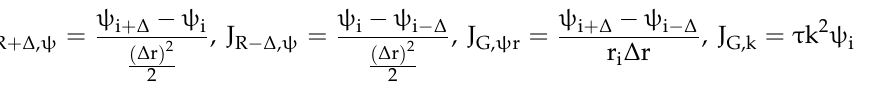
Figure 5. Nomenclature and network model of the ψ secondary circuit. Radial